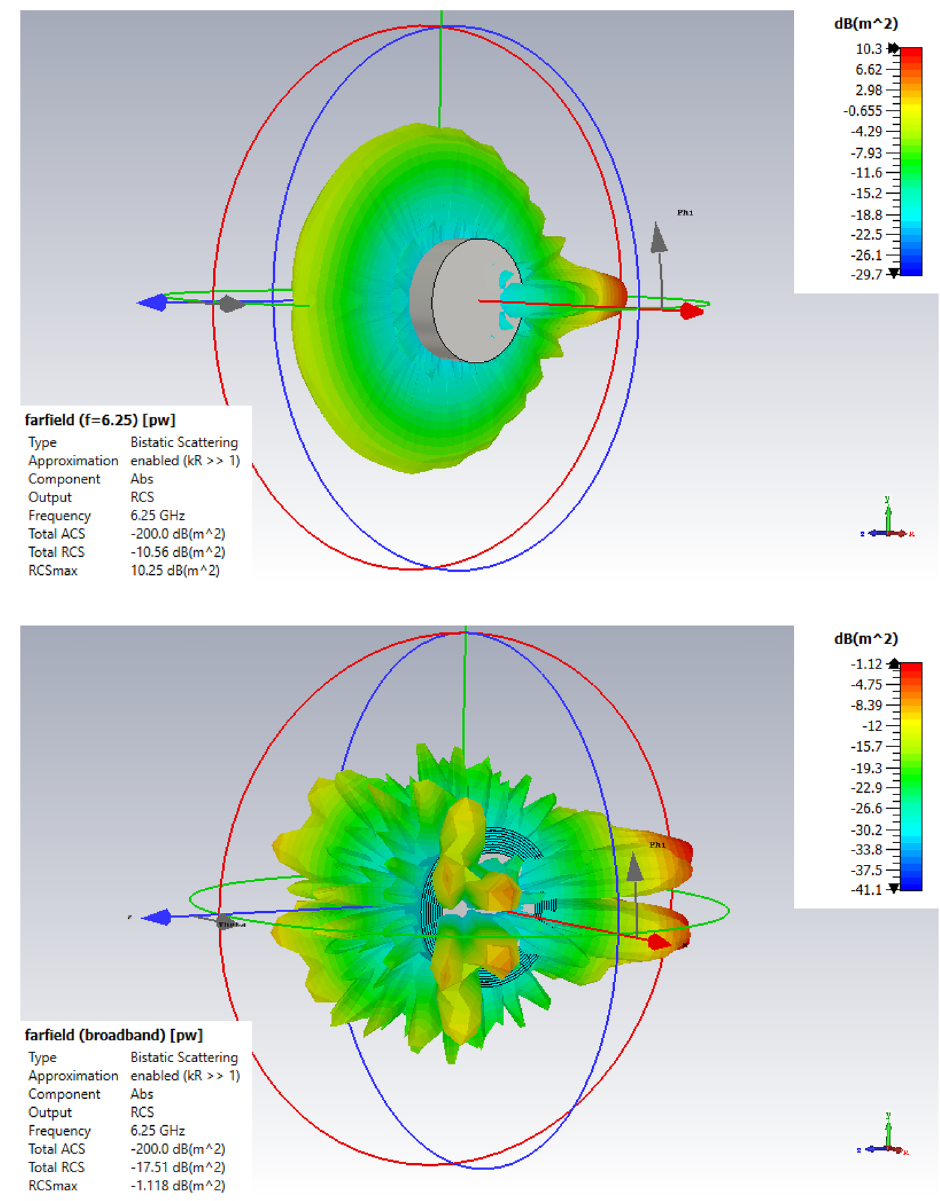
Figure 7. The far-field scattering 3D pattern for cylinder without radioactive nuclei (up) and with radioactive nuclei